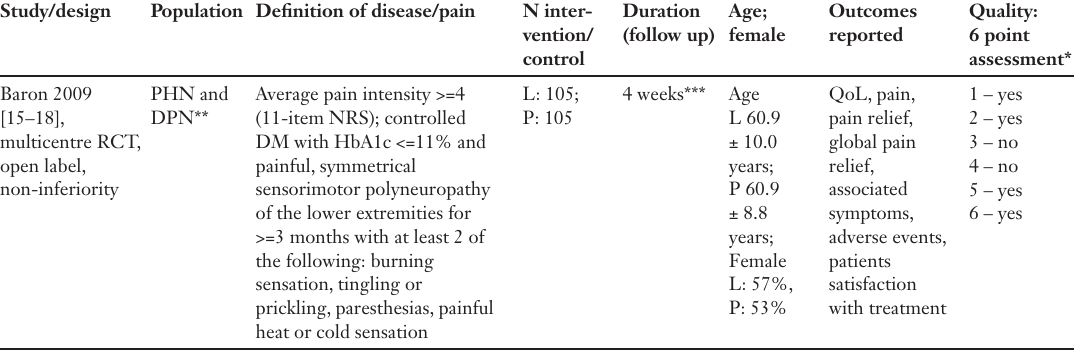
5% lidocaine medicated plaster vs pregabalin – study details and quality.